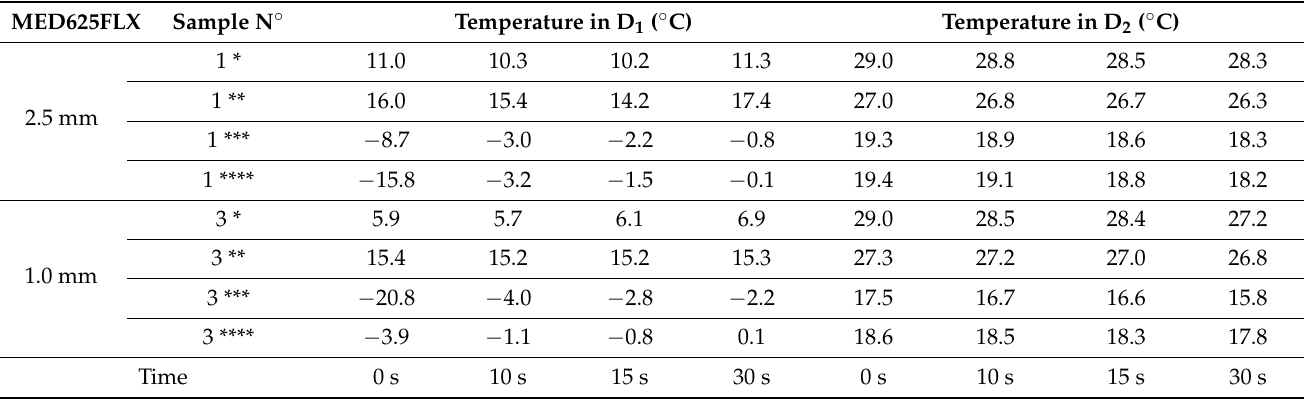
Table 3. Temperature measurements using MED625FLX samples of 1.0 and 2.5 mm for the cryo- ablation